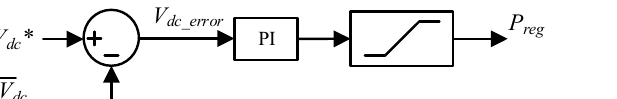
Figure 6. Block diagram of the control algorithm responsible for regulating the voltage on the common dc-link.